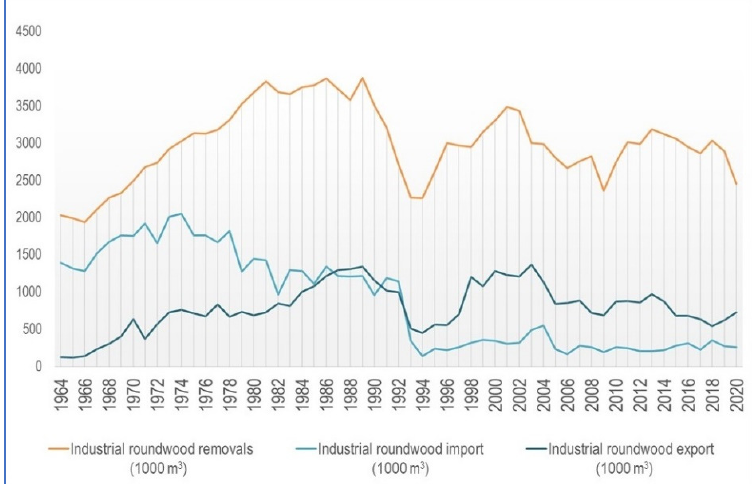
Figure 3. The proportion of industrial wood and firewood in the total net roundwood removal.